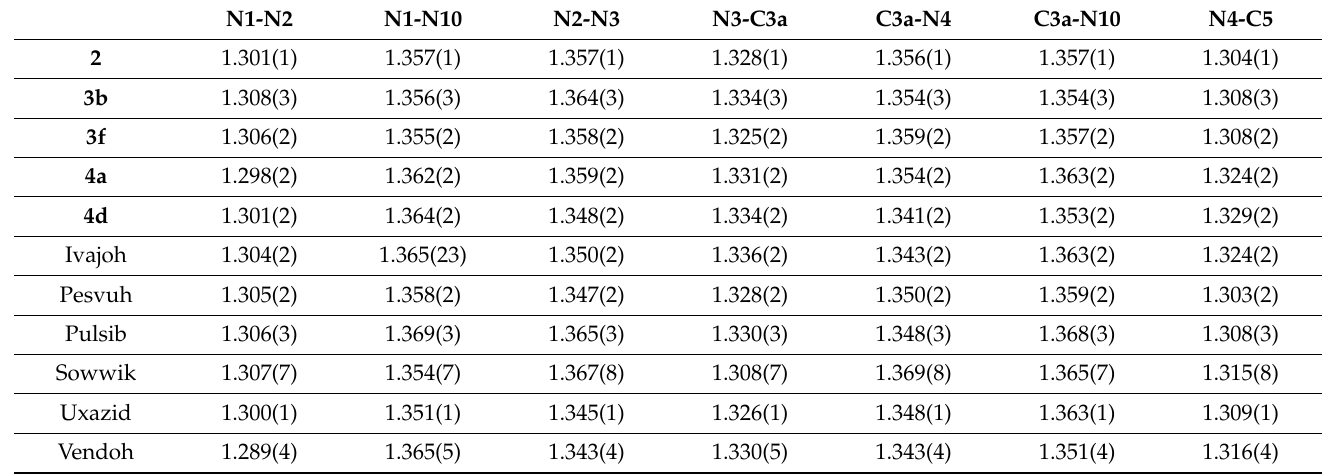
Table 2. The selected bond lengths for the studied crystal structures and data from the literature